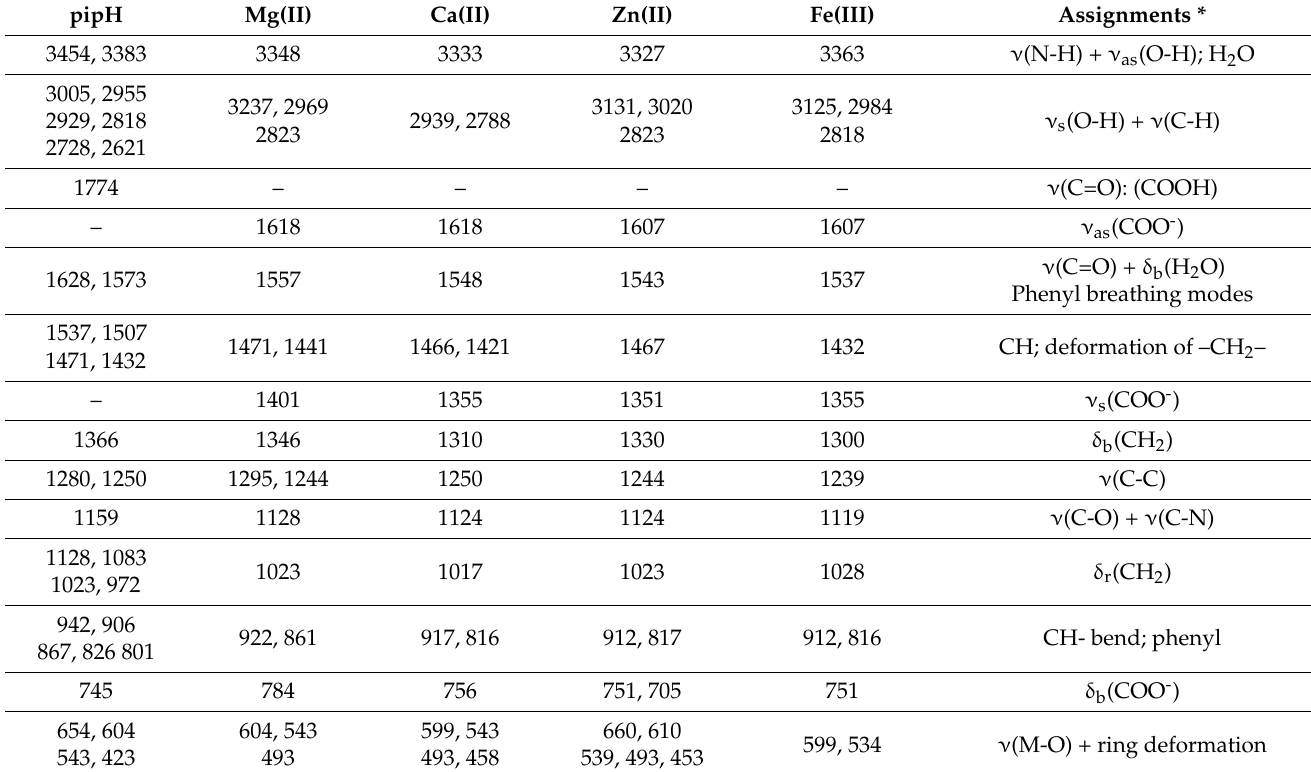
Table 2. FTIR frequencies (cm − 1 ) and assignments of pipH free ligand, pip–magnesium, calcium, zinc, and iron (III) drug complexes.